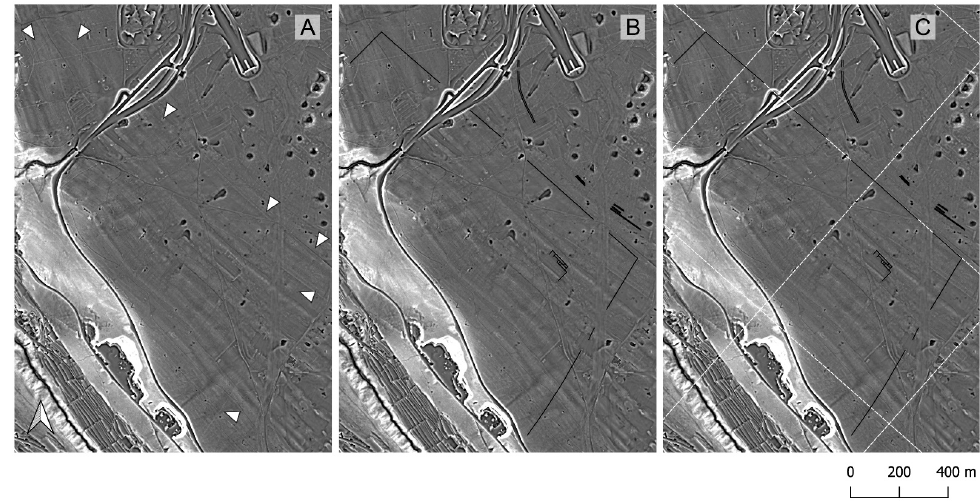
Figure 17. The rural complex of area I with the boundary walls indicated by white arrows and black lines (pictures ( A ) and ( B )) and compared with the Roman centuriation grid of the Karst (dotted white lines in picture ( C )) built fitting the main preserved limites in the Slovenian and Trieste Karst. Local relief model of an ALS-derived DTM.